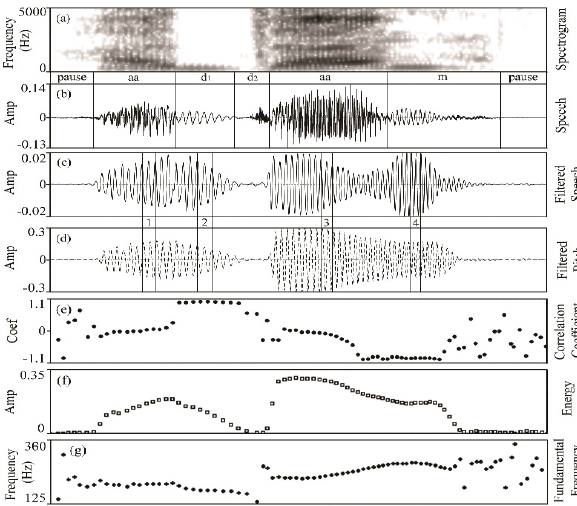
Figure 2: The example of different representations of the speech signal at the moment of pronouncing the word “Adam”. (a) The spectrogram of the source speech signal. (b) The original waveform of the source speech signal obtained from the acoustic microphone. The segmentation on the sub-phoneme level is performed manu- ally. (c) The acoustic microphone speech signal passed through the FIR filter with a pass band of 155-300 Hz. (d) The throat microphone speech signal passed through the FIR filter with a pass band of 155-300 Hz. (e) The correlation coefficients of the periods of throat and speech signals (TAC coefficients). The vertical lines mark the segment boundaries obtained as the result of the automatic seg- mentation process. (f) The energy contour. (g) The fundamental frequency contour. (h) Delta coefficients of fundamental frequency (time